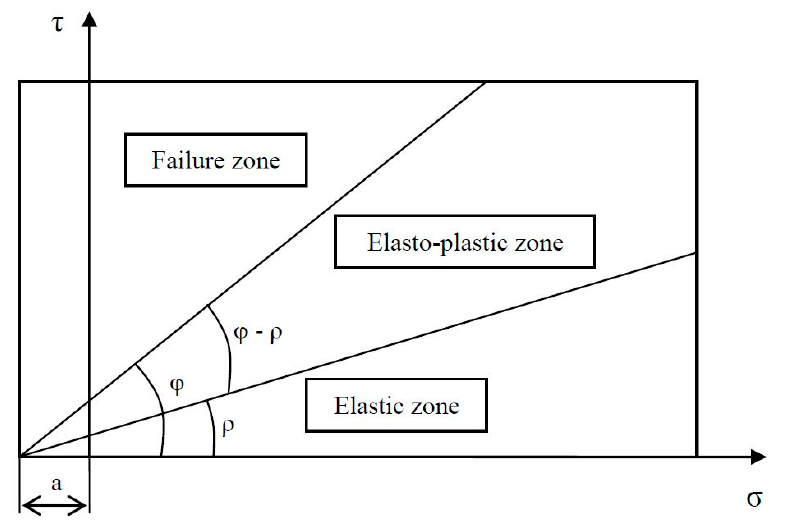
Figure 7. Material behavior classified according to mobilized shear strength ρ (°) and maximum shear to failure φ (°) in three ranges. The Coulomb approach applied to cyclic load triaxial testing is demonstrated in a τ‒σ plot, adapted from [45].